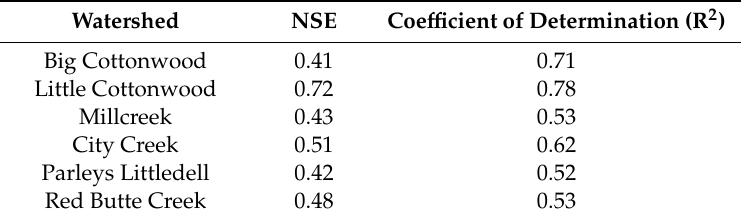
Table 6. Results of different statistical tests to evaluate the historical baseline scenario results based on average daily flow .